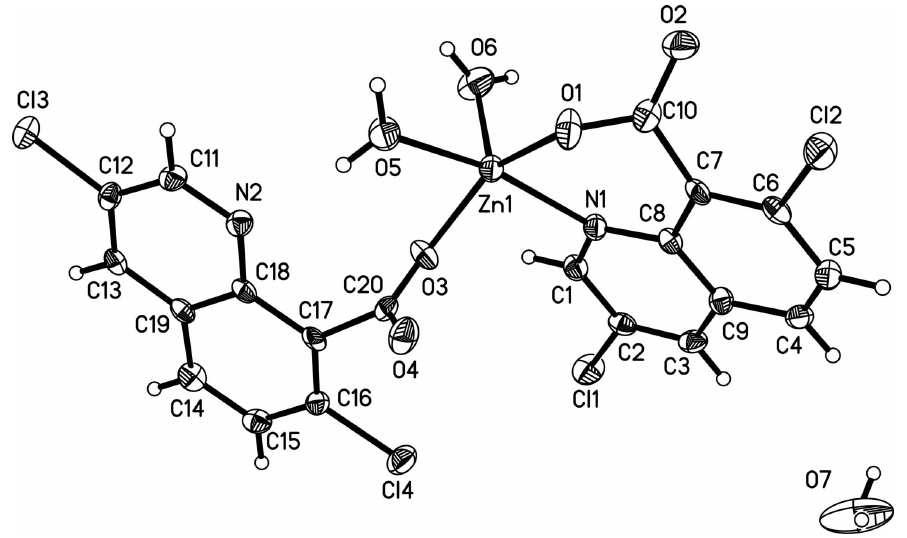
Figure 1 The structure of (I), with the atomic numbering scheme and displacement ellipsoids at the 50% probability level. All H atoms have been omitted for